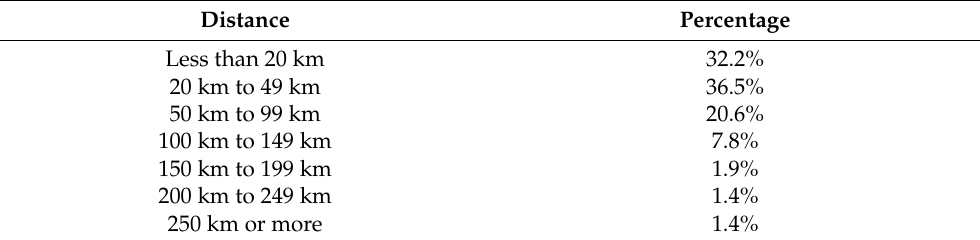
Table 3. Distance travelled on daily basis.